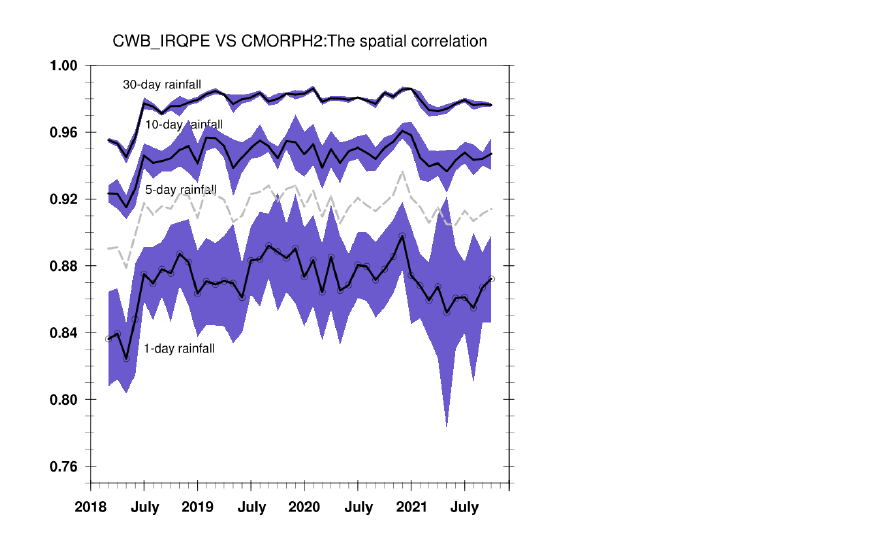
Figure 3. The spatial correlation (monthly mean: curve, standard deviation: shaded) for 4-time scales (1-day, 5-day, 10-day, 30-day) rainfall accumulation between IRQPE and CMORPH2 over Asia-Pacific (40 ◦ S–50 ◦ N, 80 ◦ E–160 ◦ W) on a spatial resolution of 1 ◦ lat/lon. Table 1. The mean correlation coefficients between IRQPE and CMORPH2 for 3 latitudinal bands and 4-time scales in 4 seasons based on the period of 2018 – 2021. The 3 latitudinal bands are Tropics